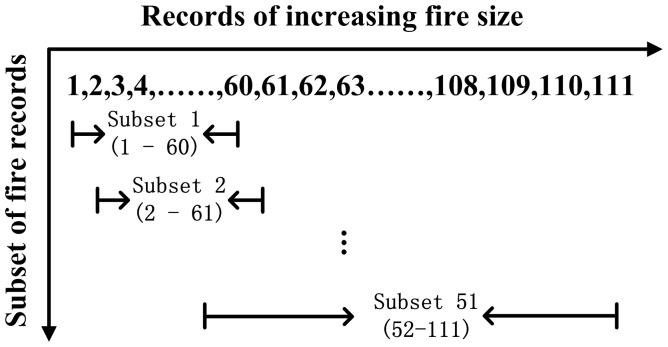
Schematic representations of resampling procedure of subset from dataset.